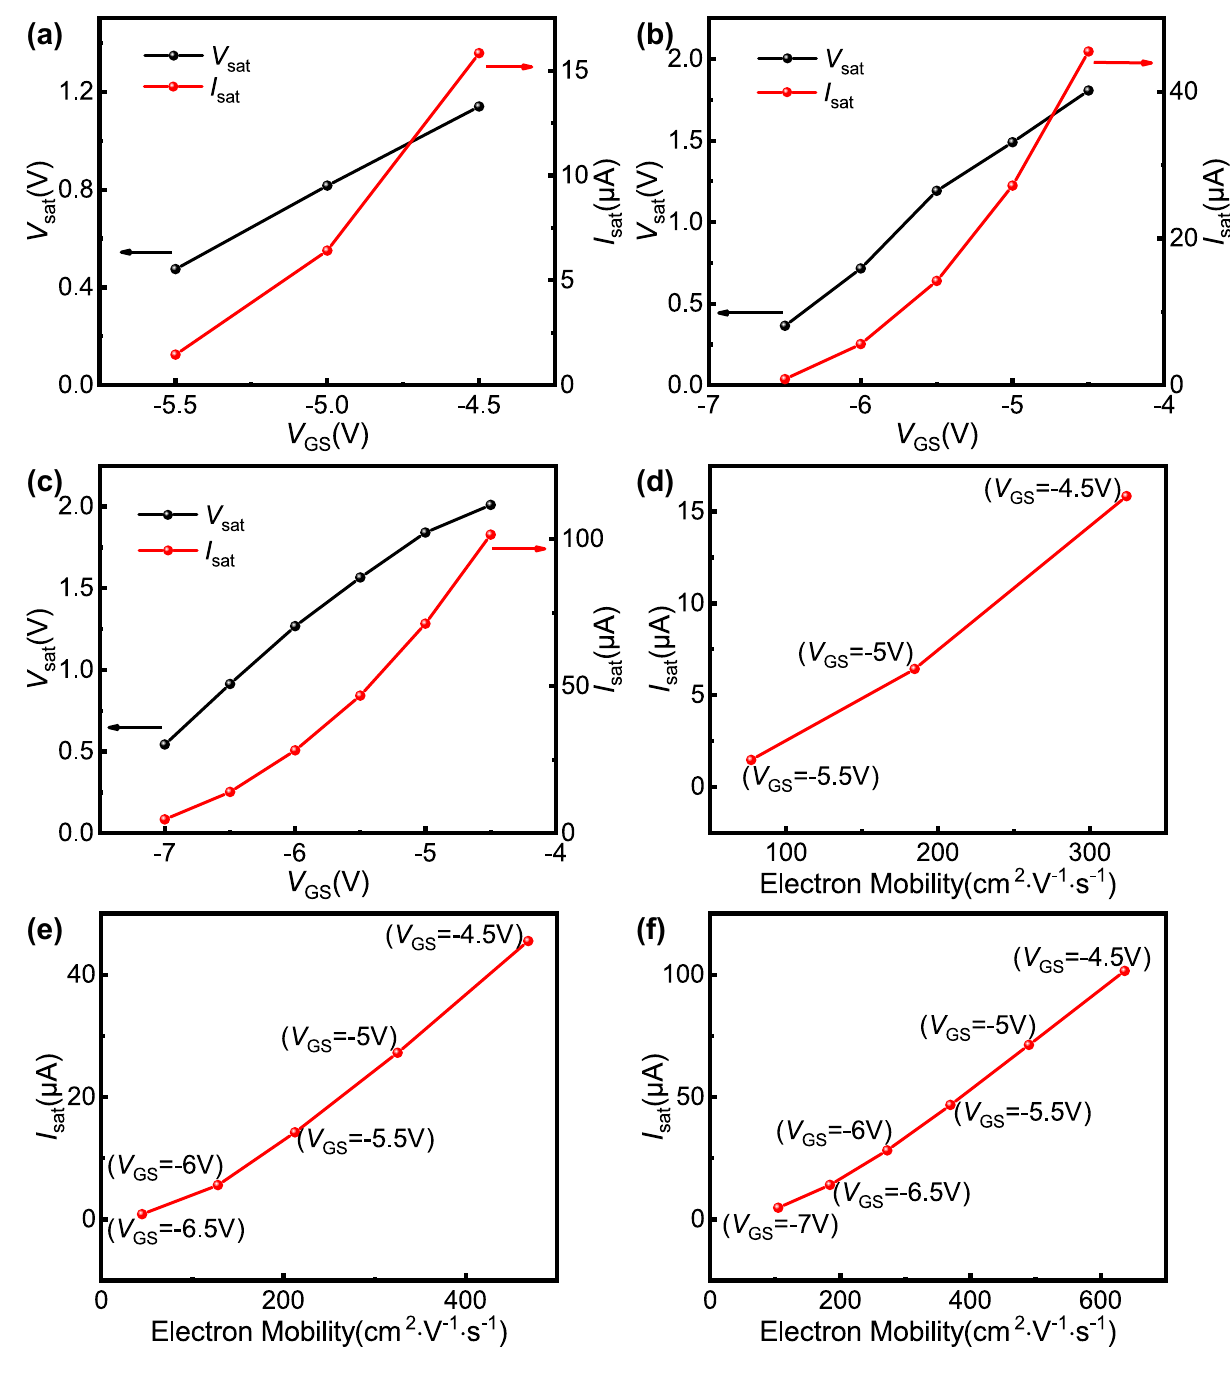
Figure 7. The measured saturation voltage and saturation current as a function of the gate bias for ( a ) sample 2, ( b ) sample 3, and ( c ) sample 4. The measured saturation current as a function of the calculated total electron mobility for ( d ) sample 2, ( e ) sample 3, and ( f ) sample 4. The saturation points are obtained by the method shown in Fig. 2. The electron mobility corresponds to the calculated total electron mobility shown in Fig.